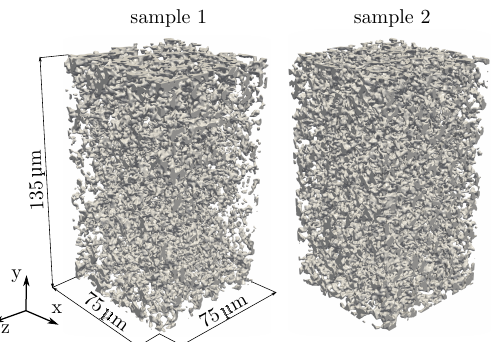
Figure 2. Reconstructed porous microstructures of the two different PPM test samples (sample 1 and sample 2), in which the gray parts show the solid membrane. Each of the presented samples exhibits a volume of (75 × 135 × 75 ) µm. Sample 1 corresponds to the SEM image in Figure